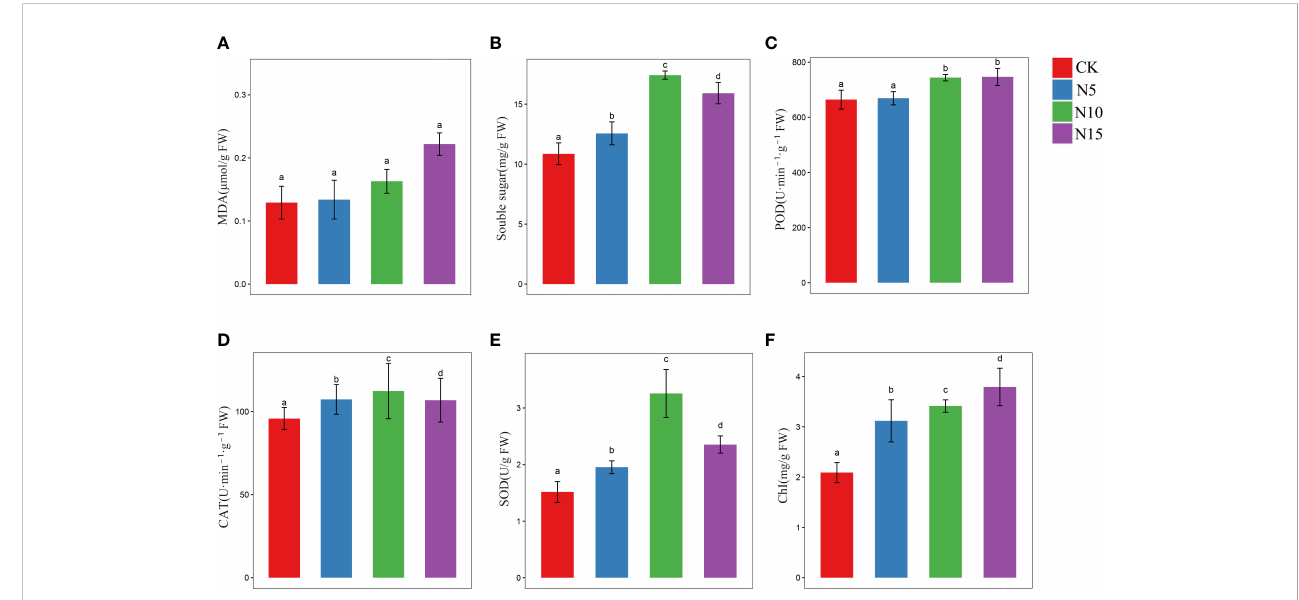
FIGURE 1 Physiological evaluate of S. canadensis in different N addition conditions. (A, B, F) The content of MDA, soluble sugar and total chlorophyll in leaves of various N level environment. (C – E) The activities of POD, SOD and CAT enzymes. The color bar represented each group (mean ± SE), and the signi fi cant differences among different N level groups was marked by letters (p <.05). The red, blue, green, and purple color bar represents CK, N5, N10, and N15 group,